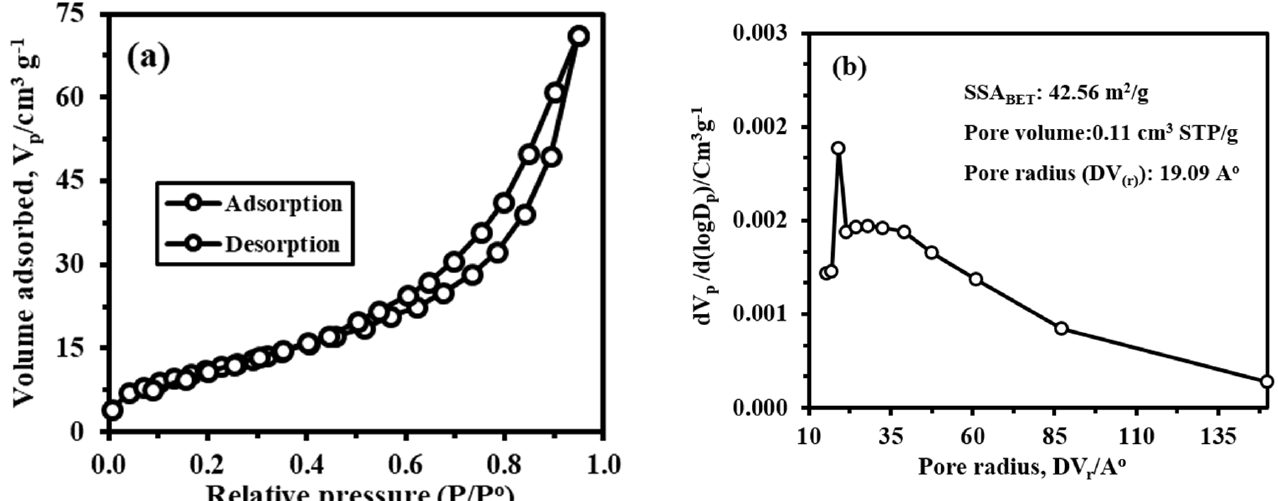
Figure 2. Textural characterization of Cys nanocomposite pore size analysis—N 2 adsorption/desorption isotherms ( a ) and pore–size–distribution ( b ).